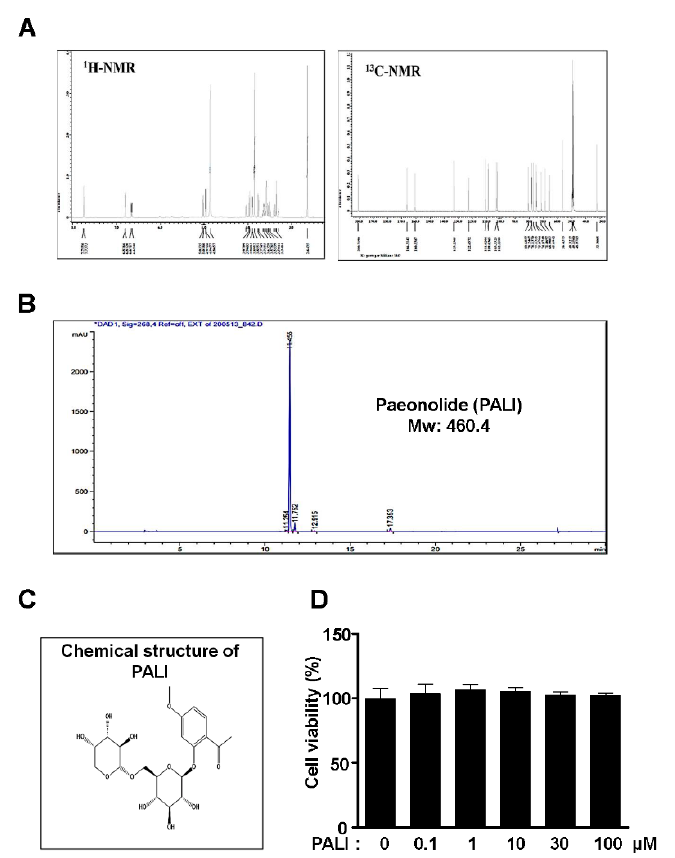
Figure 1. Effects of paeonolide (PALI) isolated from the roots of P. suffruticosa on cytotoxicity and proliferation in pre-osteoblasts. ( A ) 1 H and 13 C NMR spectra of PALI from the roots of P. suffruticosa . ( B ) HPLC chromatogram of PALI. ( C ) Chemical structure of PALI. ( D ) Pre-osteoblasts were treated with PALI at concentrations ranging from 0.1 to 100 μ M for 24 h, and cell viability (%) was measured using an MTT assay. Data are representative of the results of three independent experiments and values are expressed as mean ± SEM.